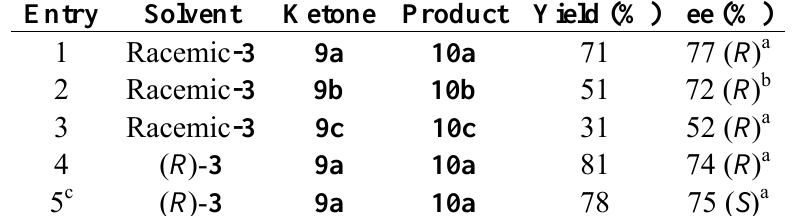
Table 2. Proline-catalysed reaction of ketones with dibenzyl azodicarboxylate. Entry Solvent Ketone